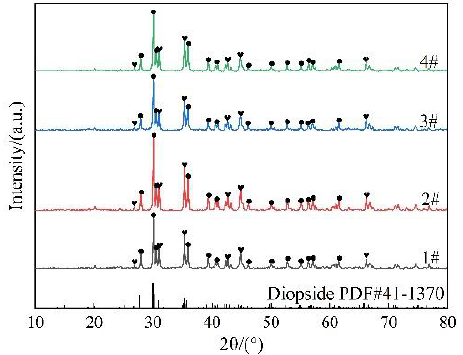
Figure 6. XRD pattern of the glass – ceramics samples.